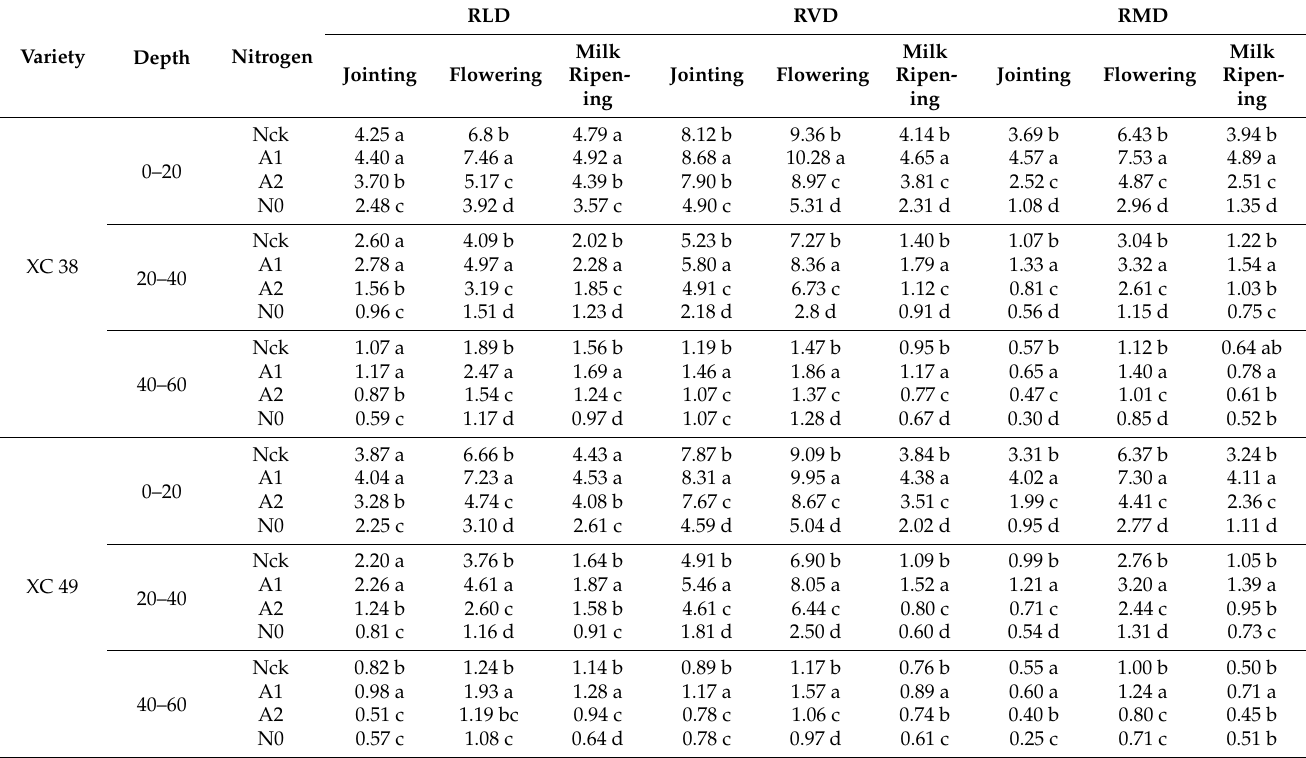
Table 1. Effect of different nitrogen application rates on the root morphology of drip-irrigated spring wheat in